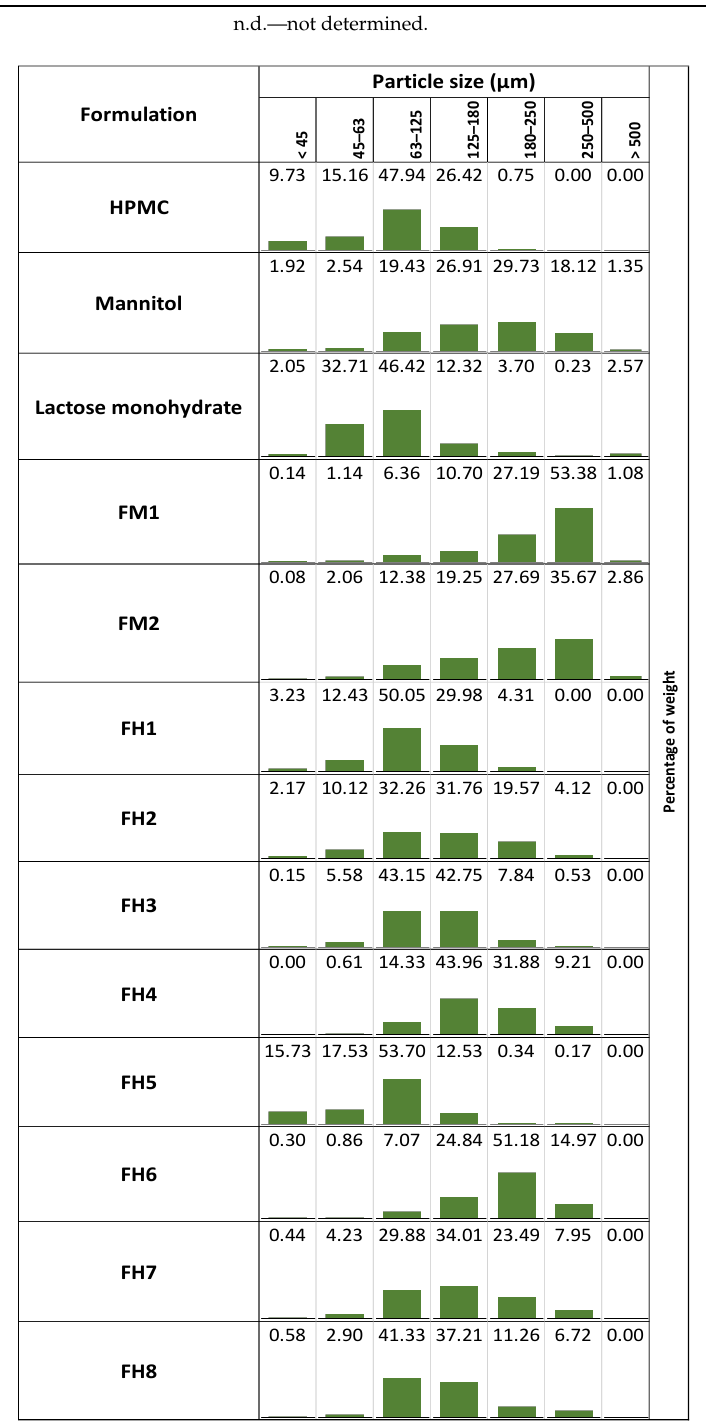
Figure 1. Particle size distribution of powder mixtures for 3D printing. From the results in Table 3, it can be concluded that formulation FM1 had fair flow characteristics, whereas FM2 had good flow characteristics. They had better flowability than other formulations due to the presence of mannitol obtained in the spray granulation process. All other formulations had passable flow characteristics, except FH8, which had poor flow characteristics. According to the results, FM1 and FM2 were not printable due to having a particle size larger than 250 µm, despite satisfactory flowability. The choice of